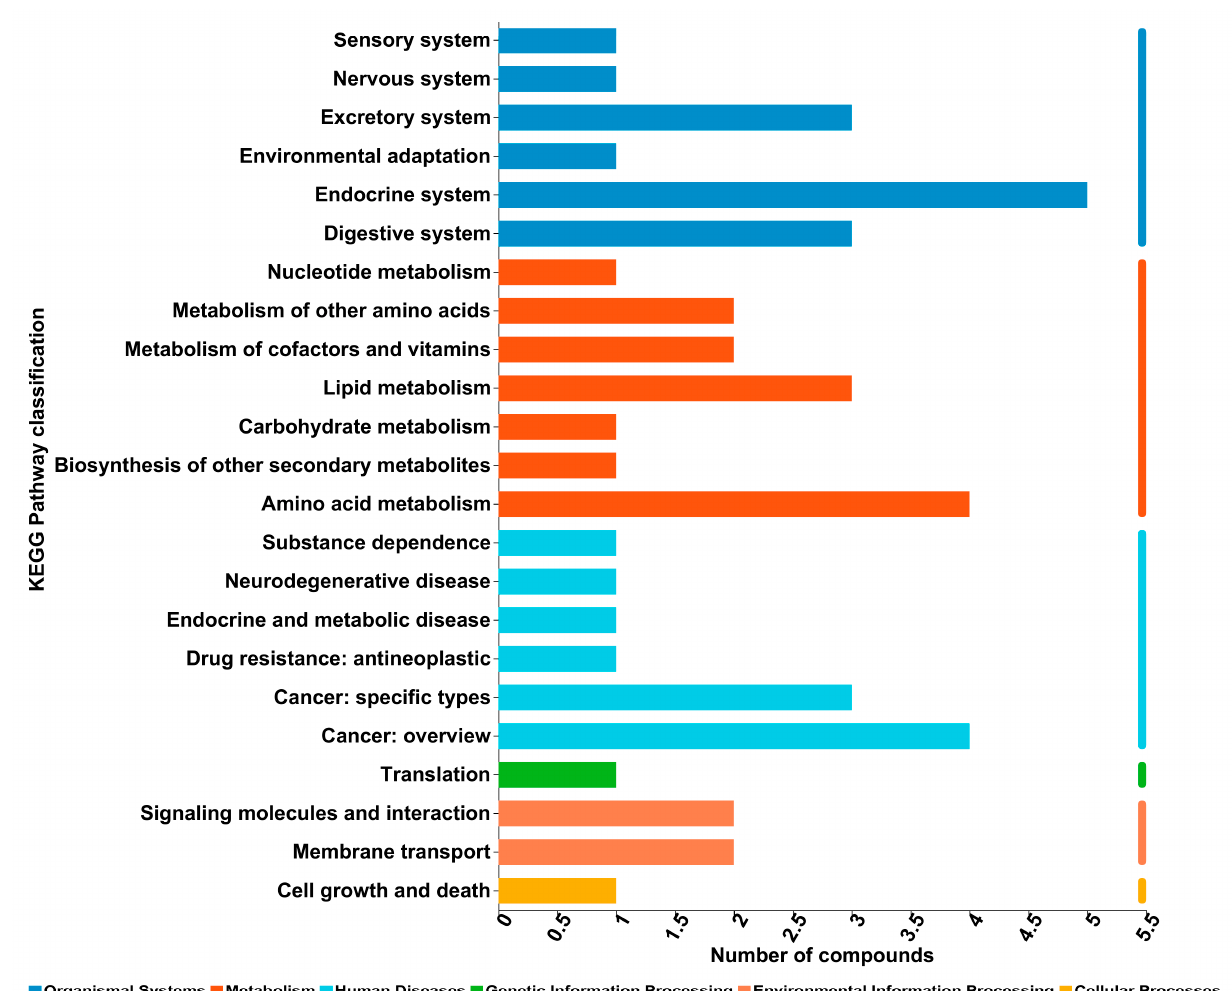
Figure 6. BS reversed the effects of the HFD on the serum metabolomic profiles of mice. Partial least squares analysis (PLS − DA) scores of the fecal metabolomics of the three groups are shown. ( A ) Positive ion; and ( B ) negative ion. ( C ) Hierarchical cluster analyses of differential metabolites. Red and blue colors with increasing intensity indicate up-regulation or down-regulation, respectively. The metabolites with VIP > 1 and p < 0.05 were determined as statistically significantly different metabolites based on the variable importance in the projection (VIP) obtained by the OPLS − DA model and the p -value generated by Student’s t test. ( D ) KEGG functional annotation pathway map. n = 6 per group, KEGG, Kyoto Encyclopedia of Genes and Genomes; NCD, normal control diet; NCD − BS, normal control diet supplemented with freeze − dried powder of bamboo shoots; HFD, high-fat diet; HFD − BS, high − fat diet supplemented with freeze − dried powder of bamboo shoots.